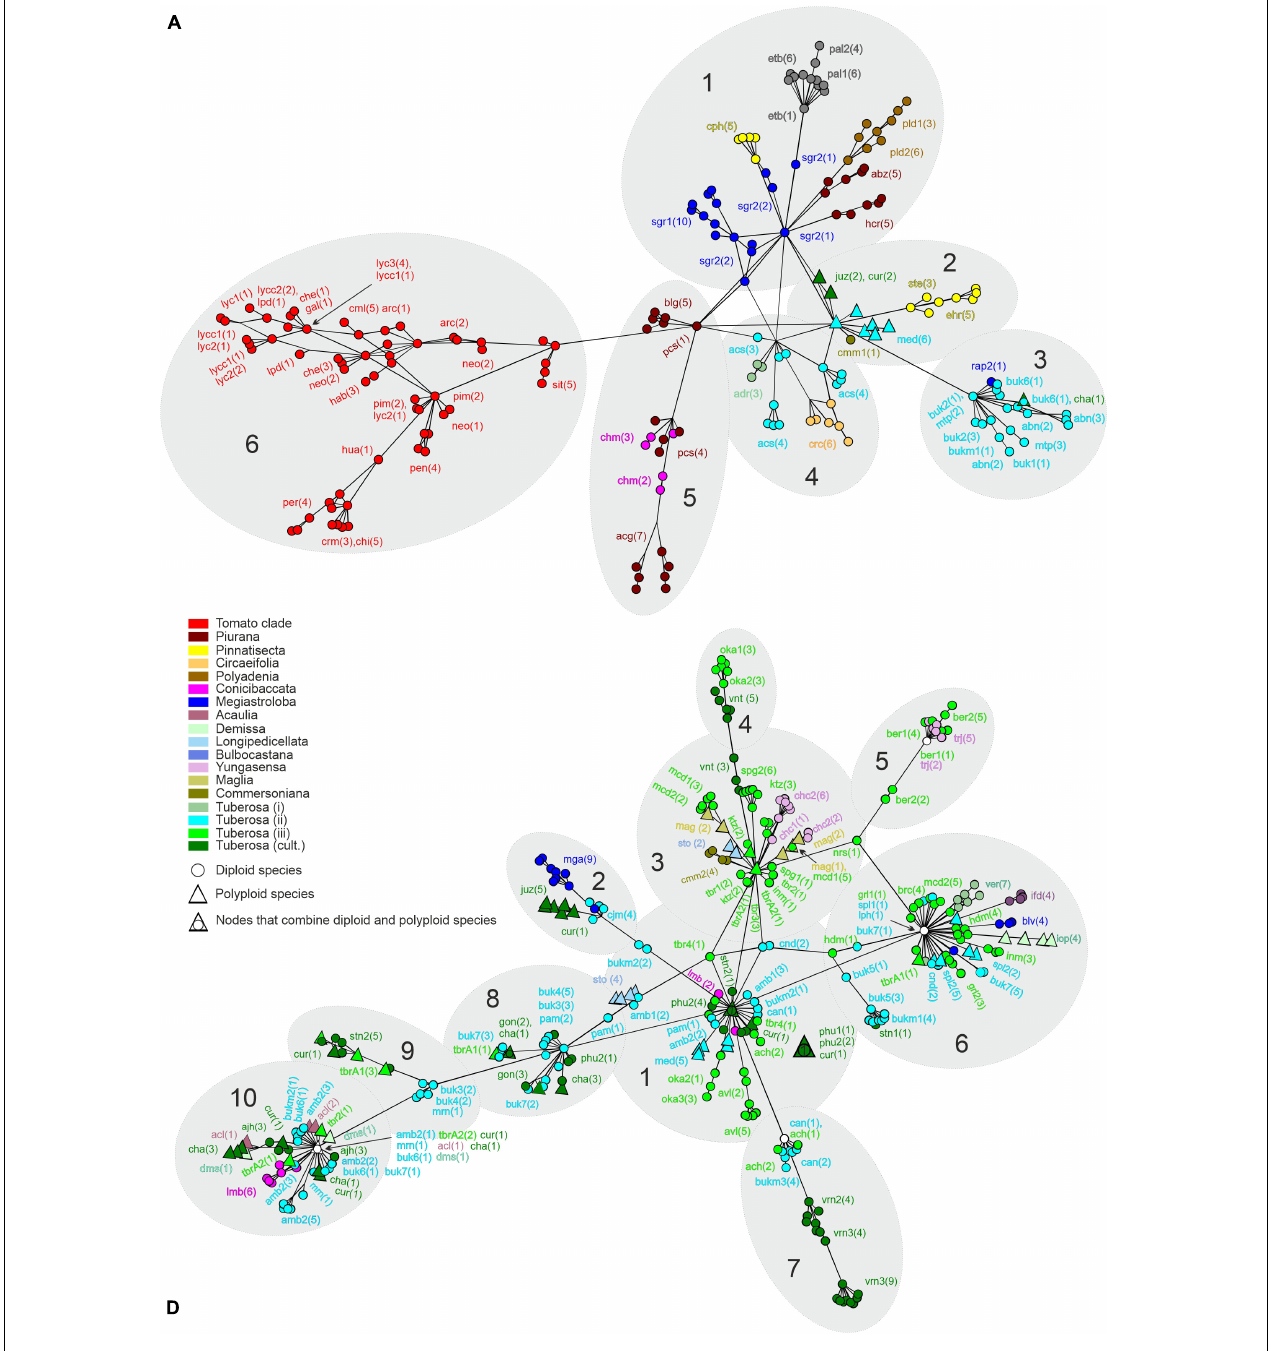
FIGURE 8 | Median-joining networks depicting relationships of 5S IGS structural variants A and D of the species of sect. Petota . Names of main clusters are given. The affiliation of the species to the series proposed by Hawkes (1990) is indicated by different colors. Numbers in brackets indicate the number of ribotypes used. Abbreviations of species names are given in Table 2